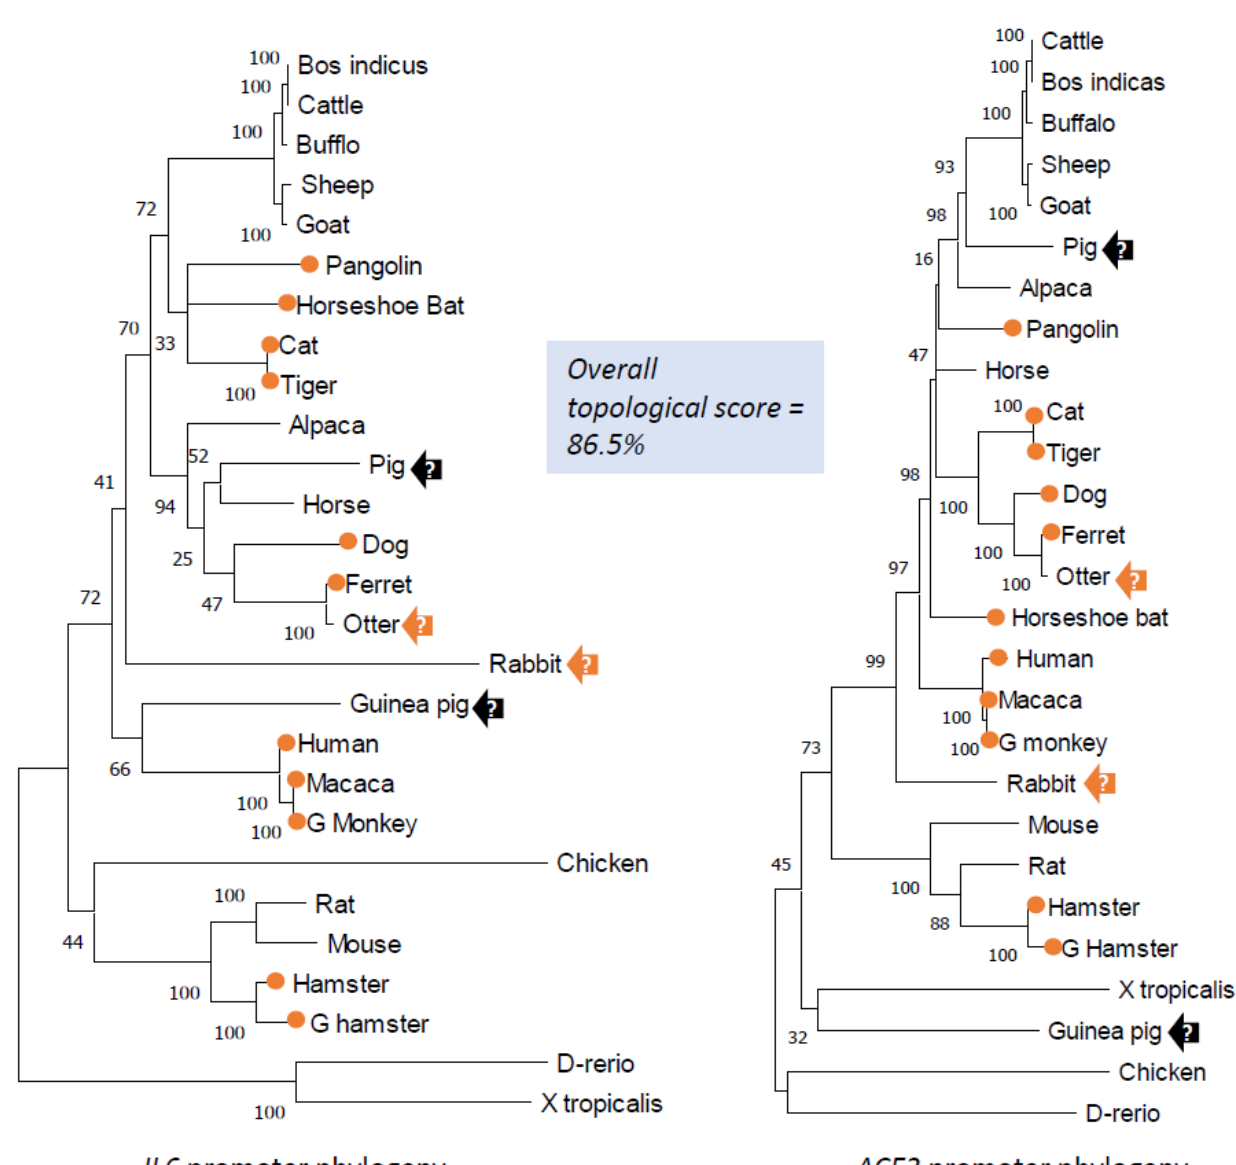
Figure 7. Cross-species phylogenic and topological comparison of IL-6 and ACE2 gene promoters. Evolutionary analyses were conducted in MEGA X. The evolutionary history was inferred by using the maximum likelihood method and Tamura – Nei model. The tree with the highest log likelihood (-52,755.39) is shown. The percentage of trees in which the associated taxa clustered together is shown next to the branches. Initial tree(s) for the heuristic search were obtained automatically by applying Neighbor-Join and BioNJ algorithms to a matrix of pairwise distances estimated using the Tamura – Nei model, and then selecting the topology with superior log likelihood value. For topological comparison between phylogenic trees generated using IL-6 and ACE2 gene proximal promoters, the phylogenies of Newick strings were generated using MEGA, and topological comparison between the Newick trees was performed with Compare2Trees at (http://www.mas.ncl.ac.uk/~ntmwn/compare2trees) to obtain the overall topological scores. Orange circle: COVID-19 susceptible species. Arrows: other tentative marker species to determine which group (IL-6 or ACE2) of non-ISGs are more determined for COVID-19 susceptibility. Abbreviations are as in Figure 4.